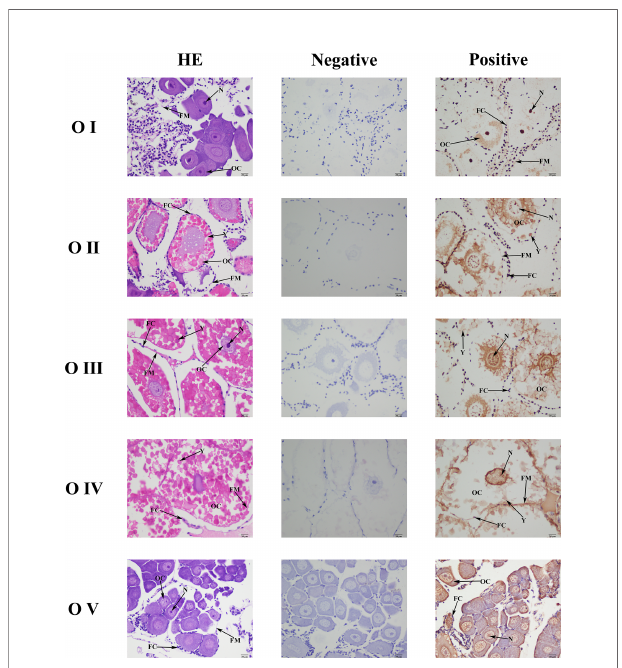
FIGURE 6 | Location of Mn-CL2 detected in the ovary by in situ hybridization. A Photograph of M. nipponense ovary in ovarian cycle. OC, oocyte; N, nucleus; CM, cytoplasmicmembrane;Y, yolkgranule;FC, folliclecell; FM,folliclemembrane; Scale bars: